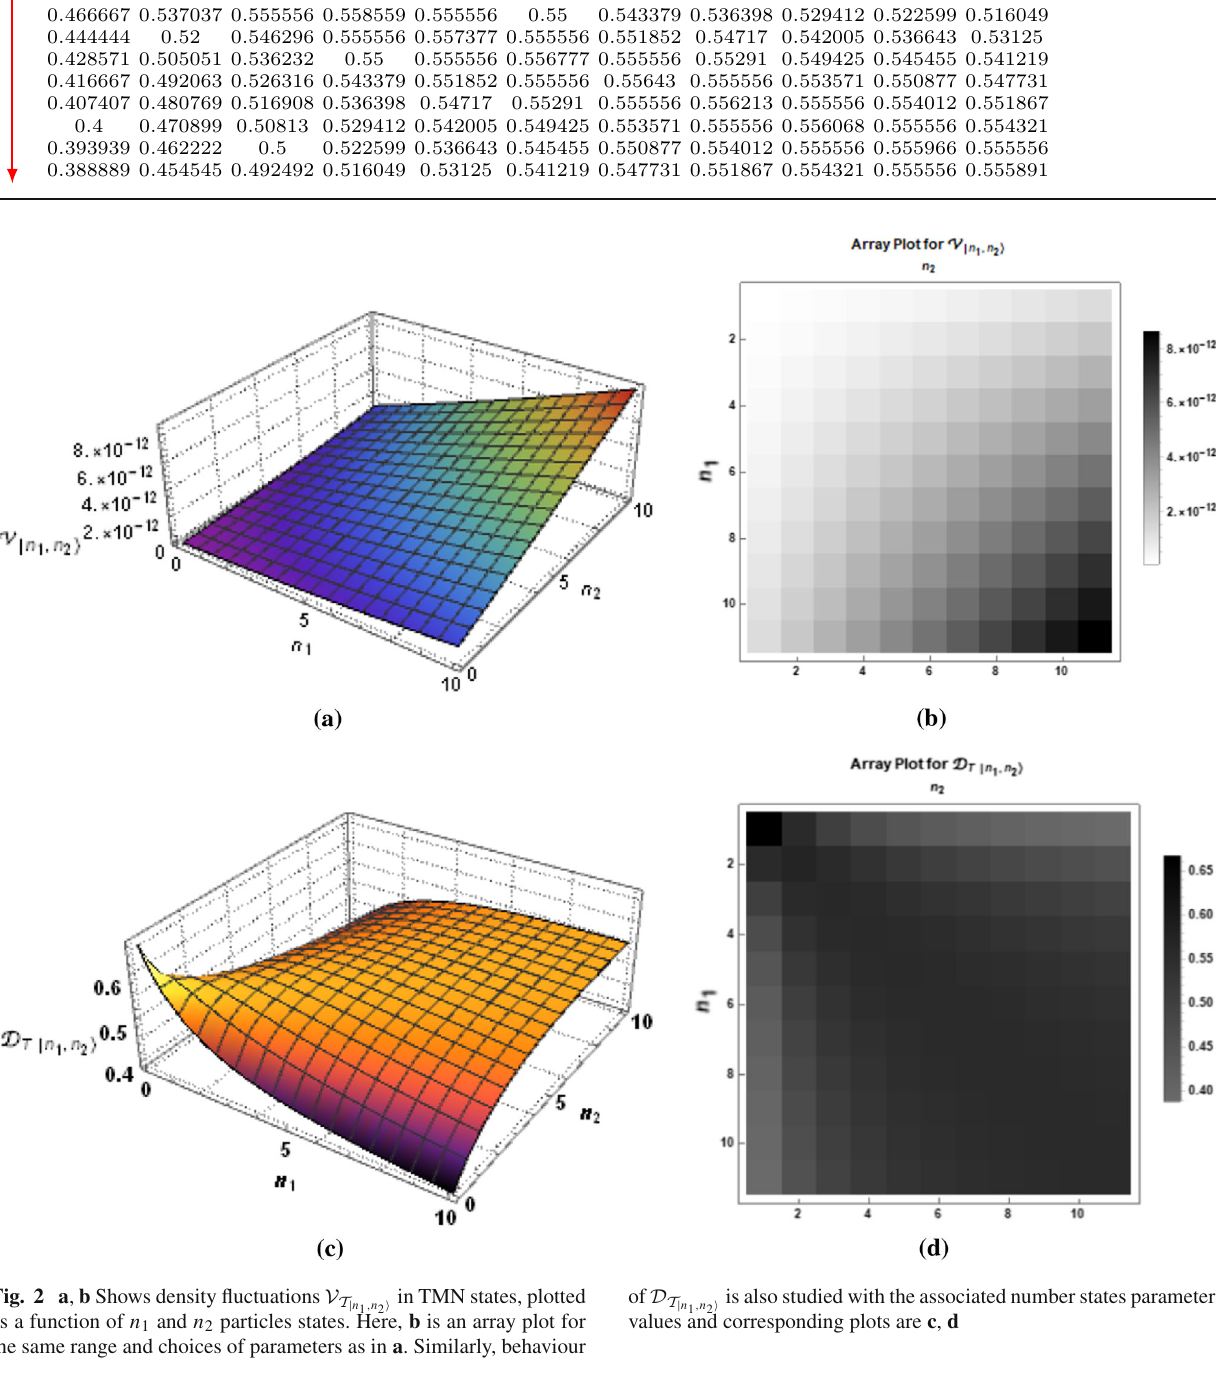
in TMN states, plotted is also studied with the associated number states parameters of D T | n 1 , n 2 (cid:3) n 1 , n 2 (cid:3) values and corresponding plots are c ,